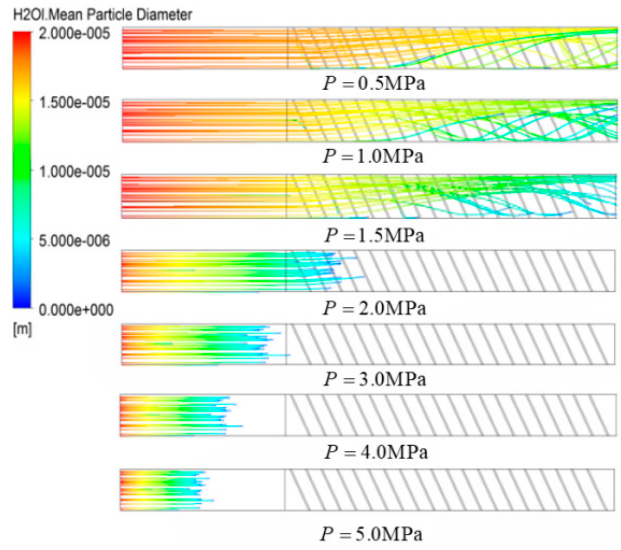
Figure 12. Variation in the droplet motion trajectory of the mist/steam cooling channel with the operating pressure.